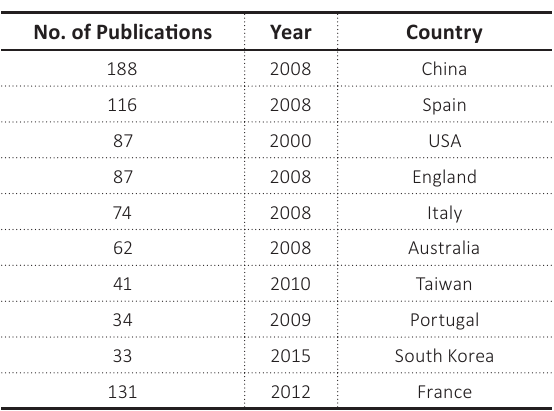
Table 3. Top countries in digital tourism research